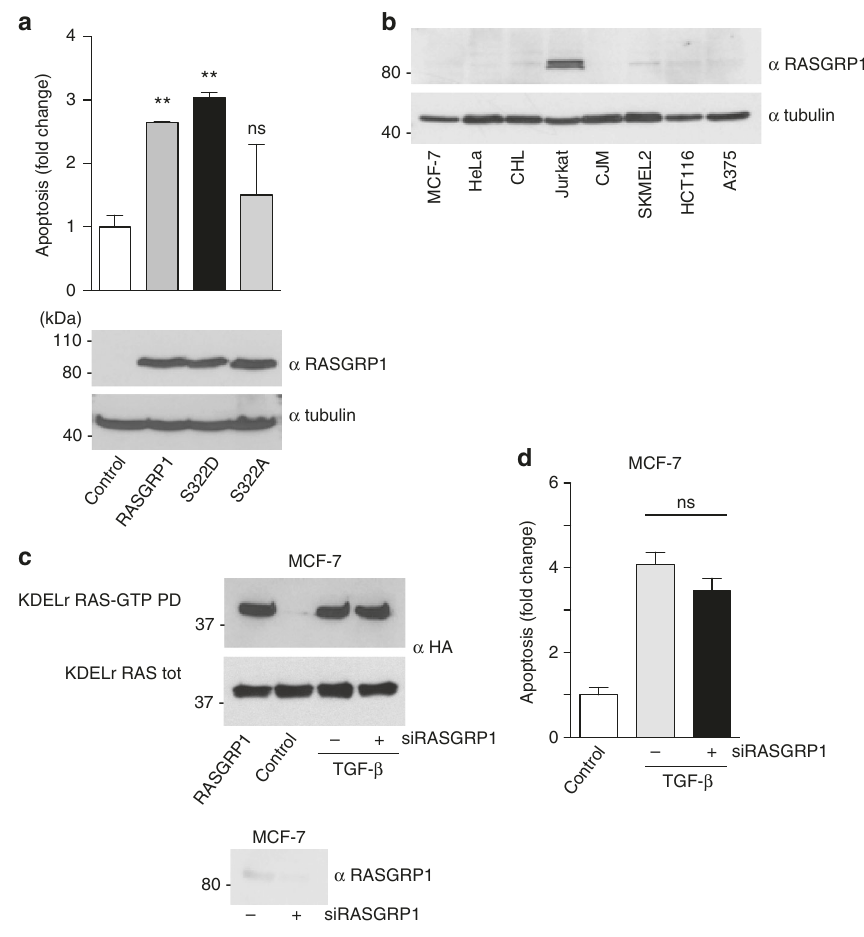
Fig. 4 Role of RASGRP1 in the GC RAS-mediated apoptotic response. a Induction of apoptosis by GC-speci fi c RAS GEFs in MCF-7 cells transfected with the indicated constructs (1 μ g each). b RASGRP1 expression levels in the indicated cell lines. c RASGRP-1 role in TGF- β -induced RAS activation. MCF-7 cells transfected with HA-tagged KDELr HRAS (0.5 μ g), in control cells or treated with TGF- β (5 ng/ml) for 10 min in the presence ( + ) or absence of a siRNA (100 nM) against RASGRP1. Cells transfected with RASGRP1 (1 μ g) ( + ) serve as positive control. GTP loading was assayed by GST-RBD pull-down (RAS-GTP-PD). d RASGRP-1 role in TGF- β -induced apoptosis in MCF-7 cells. Data show average ± SEM from three independent experiments. ns >0.05; ** p < 0.01 by Student's t